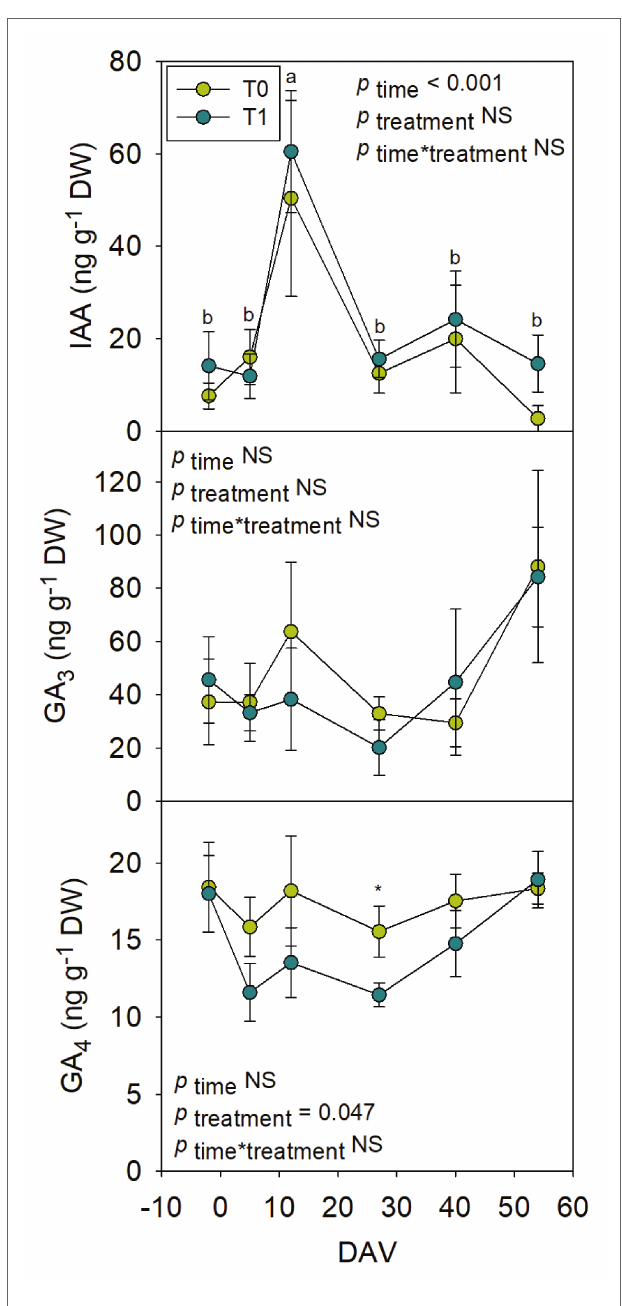
FIGURE 3 | Endogenous variations in auxin and gibberellins in whole berries of “Merlot” grapes during ripening in non-irrigated (T0) and irrigated (T1) vineyards. Indole-3-acetic acid (IAA), GA 3 , and GA 4 contents in grapes throughout ripening are shown. Vertical bars indicate SE of six replicates. Different letters denote significant differences among sampling dates (Tukey’s HSD post-hoc test p < 0.05). The asterisks indicate significant differences between treatments ( p <